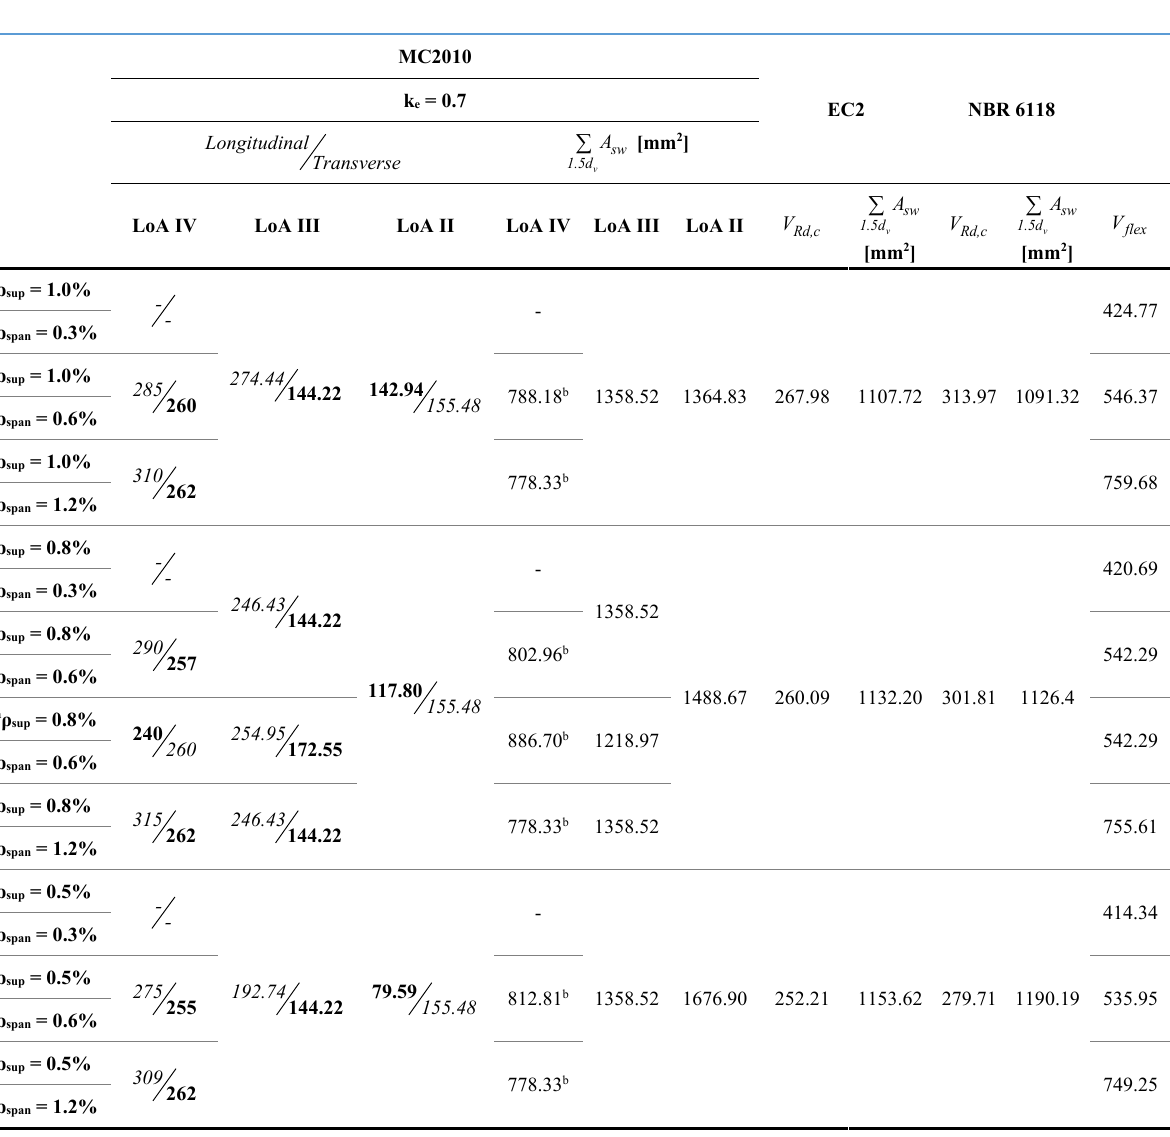
Table 4. Rd,c V and A ∑ from MC2010 LoA II to IV, EC2, NBR6118, and flex V . Shear forces in sw 1.5d v